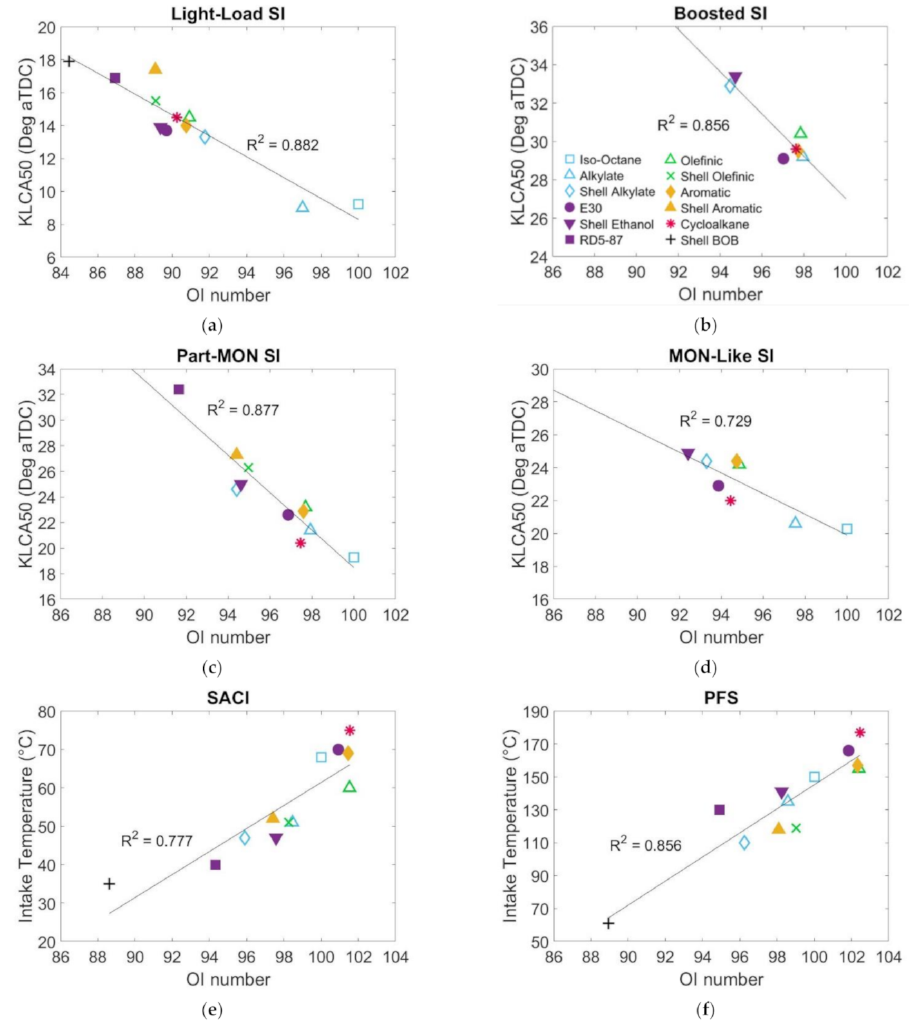
Figure 13. OI for fuels under ( a ) part-load SI, ( b ) boosted SI, ( c ) part-MON SI, ( d ) MON-like SI, ( e ) SACI, and ( f ) PFS